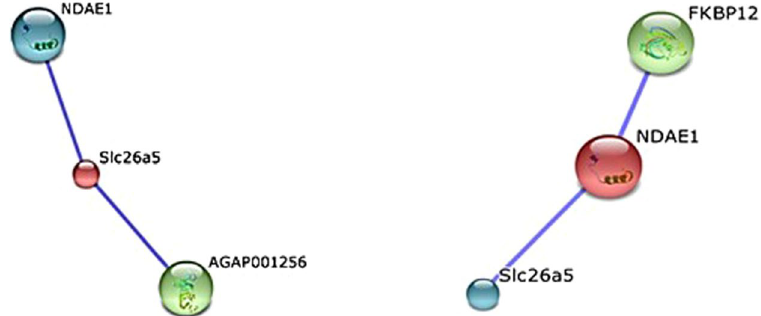
Figure 2. Predicted networks of selected solute carriers. STRING-based network prediction analysis of the prestinA and NDAE1 genes, respectively, considering a minimum required interaction score of 0.700 (high confidence).